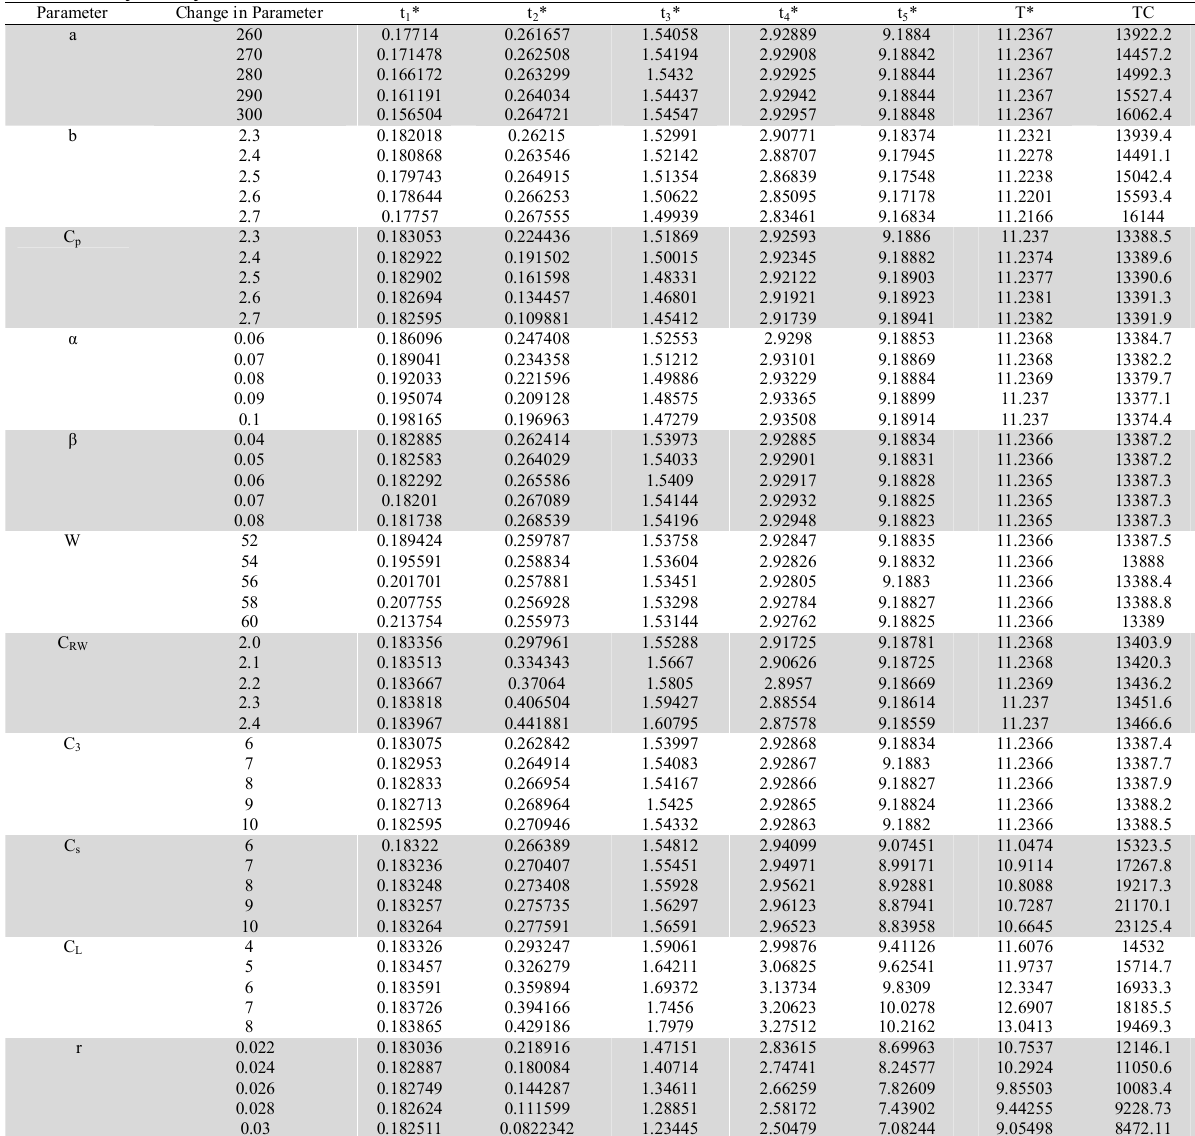
Fig. 3. Convexity of t Sensitivity analysis of model 1